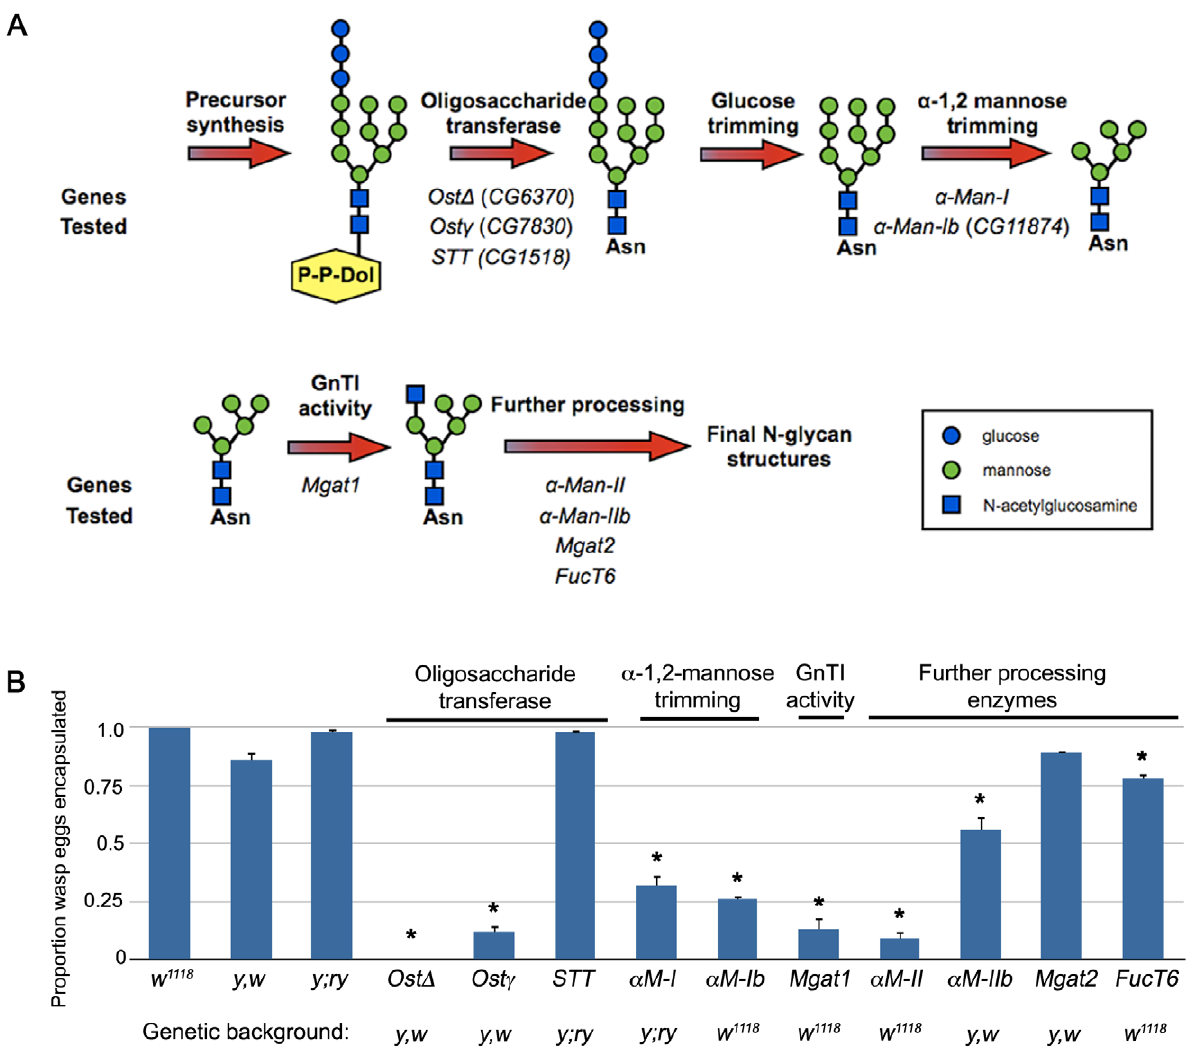
Figure 2. Multiple N-glycosylation pathway mutants fail to encapsulate L. clavipes eggs. (A) Schematic representation of the N- glycosylation pathway [adapted from 65]. The Drosophila orthologs of pathway members tested by mutant analysis are indicated and grouped according to function. Structures are drawn according to [28]. (B) Proportion of L. clavipes eggs encapsulated in the indicated genotypes, demonstrating encapsulation deficiency of multiple pathway mutants. Error bars indicate standard error of the mean; * indicates p , 0.01 compared to indicated genetic background control; a -M-I: a -Man-I; a -M-Ib: a -Man-Ib; a -M-II: a -Man-II; a -M-IIb: a -Man-IIb.